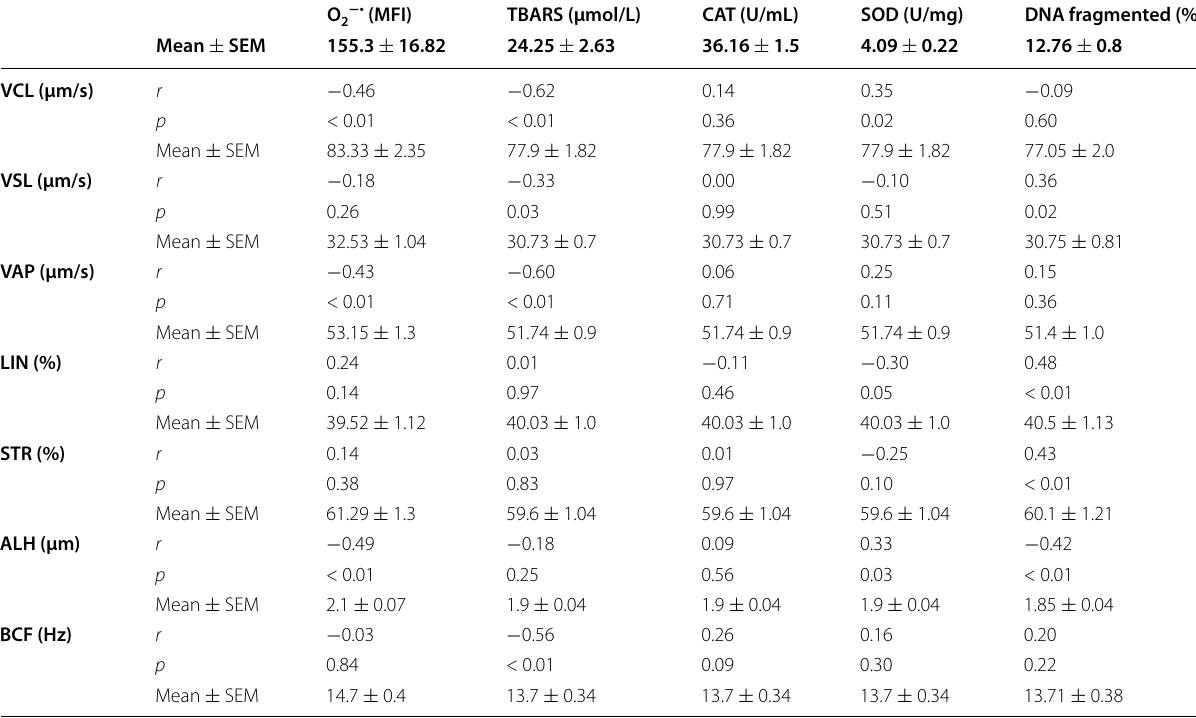
O 2 − • superoxide anion, MFI Median DHE fluorescence intensity, TBARS Thiobarbituric acid reactive substances, CAT Catalase, SOD Superoxide dismutase, VCL Straight line velocity, VSL Average path velocity, VAP Average path velocity, LIN Linearity, STR Straightness, ALH Lateral head displacement, BCF Beat cross